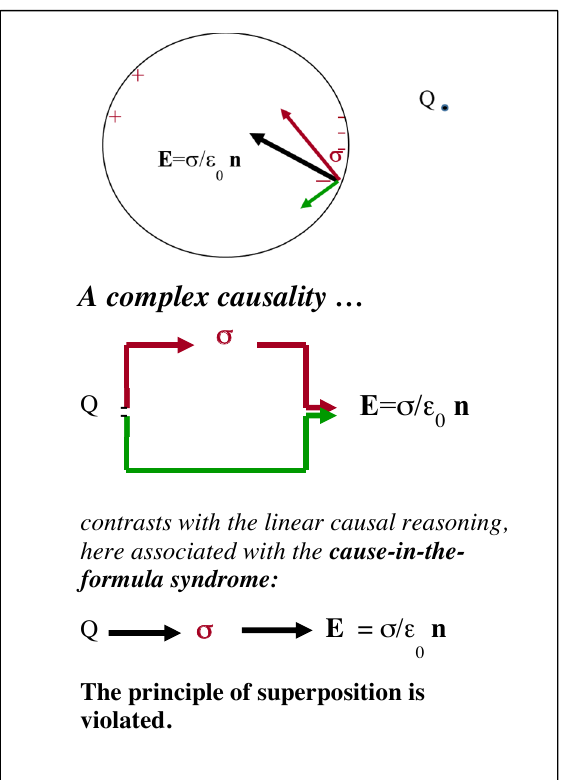
Fig. 3. The electric field near a conducting body at equilibrium is created by all the charges in the universe, not only by the surface charges on the body, σ